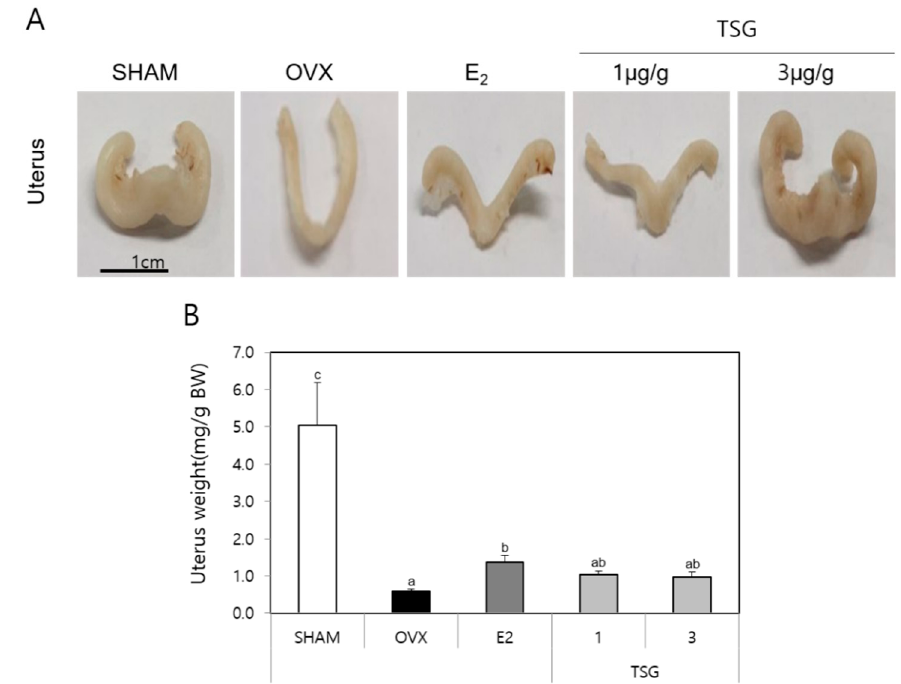
Figure 2. Effect of TSG on uterus weight. The C3H/HeN mice were treated with TSG for 6 weeks, and the uteri were harvested 24 h after the last treatment. ( A ) The uterus was photographed with a digital camera and ( B ) weighed. a, b, and c: The means not sharing a common letter are significantly different among group at p < 0.05 by one-way ANOVA with Duncan’s multiple-range test.